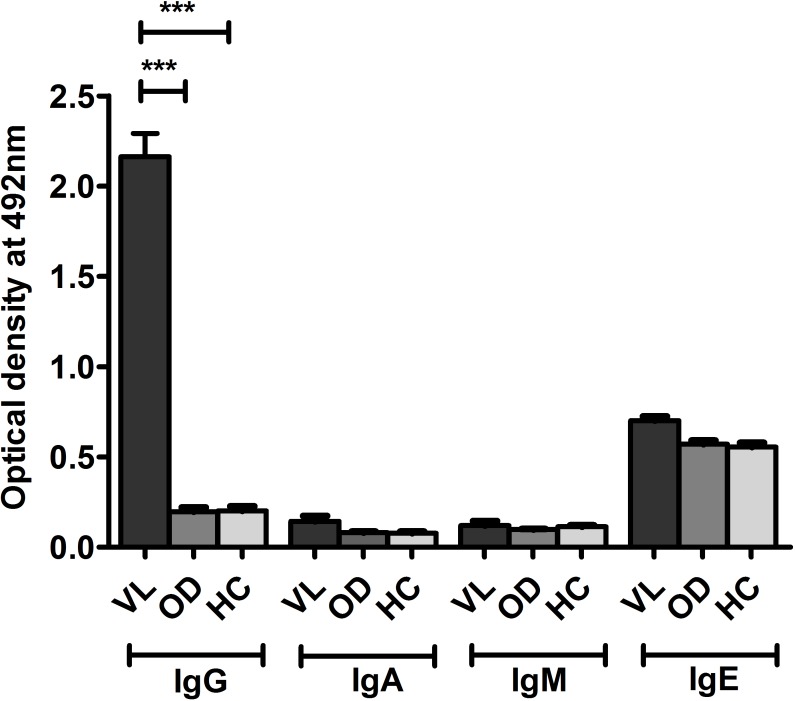
ELISA to determine relative antibody isotype titres in urine of VL patients and negative controls.Graph showing comparative optical density values of LAg-specific antibody isotypes; IgG, IgA, IgM, and IgE present in the urine samples of VL patients (n = 5), healthy controls (HC) (n = 3) and other diseases (OD) (n = 4) at 492nm.